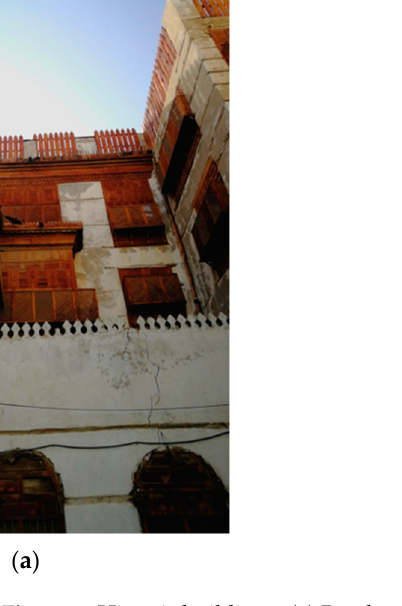
Figure 2. Historic buildings: ( a ) Baeshen House and ( b ) Zainal